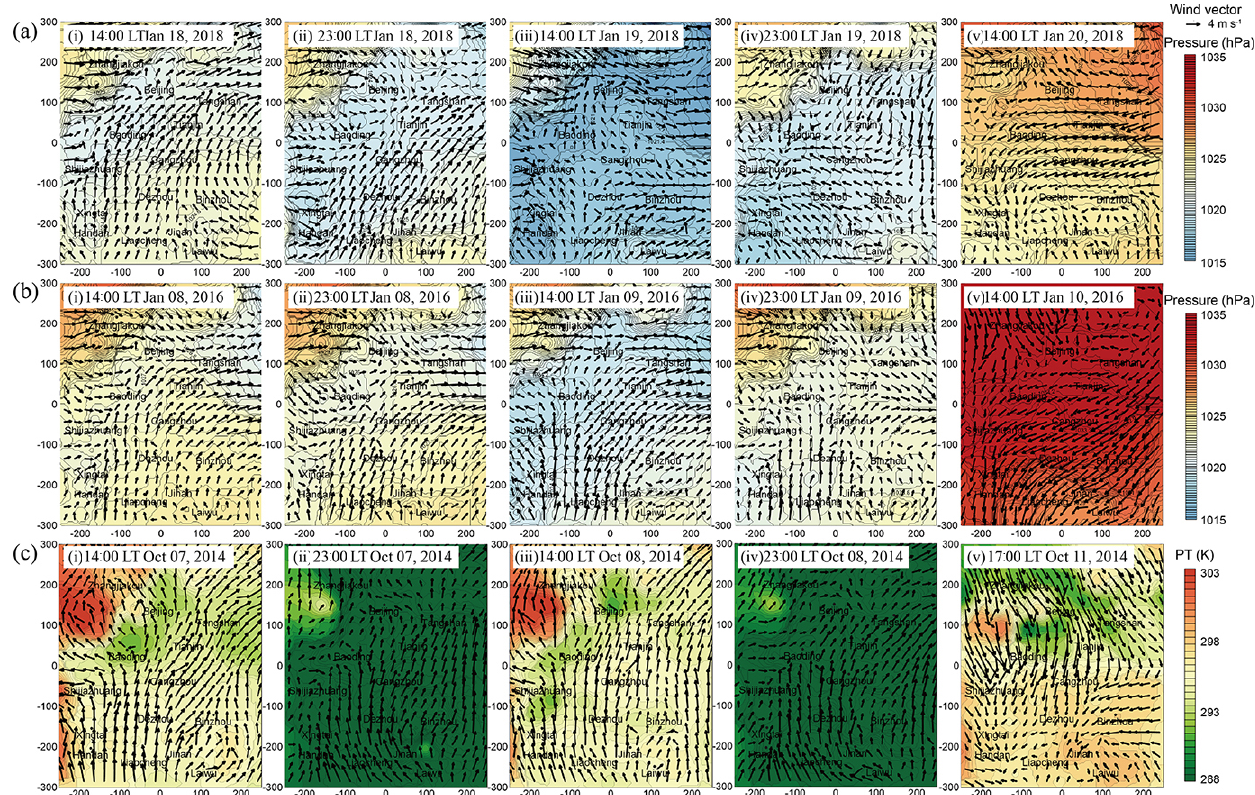
Figure 5. Observed sea-level pressure/potential temperature and wind vectors at the pollution stages of (i) formation, (ii–iv) maintenance, and (v) diffusion during representative cases 1–3 under (a) west–southwest wind shear mode, (b) south–north wind shear mode, and (c) to- pographic obstruction category. The shaded colors represent the sea-level pressure in (a–b) and the potential temperature in (c) . The arrows indicate wind vectors. Values shown on x and y axes denote the distances (km) to the domain